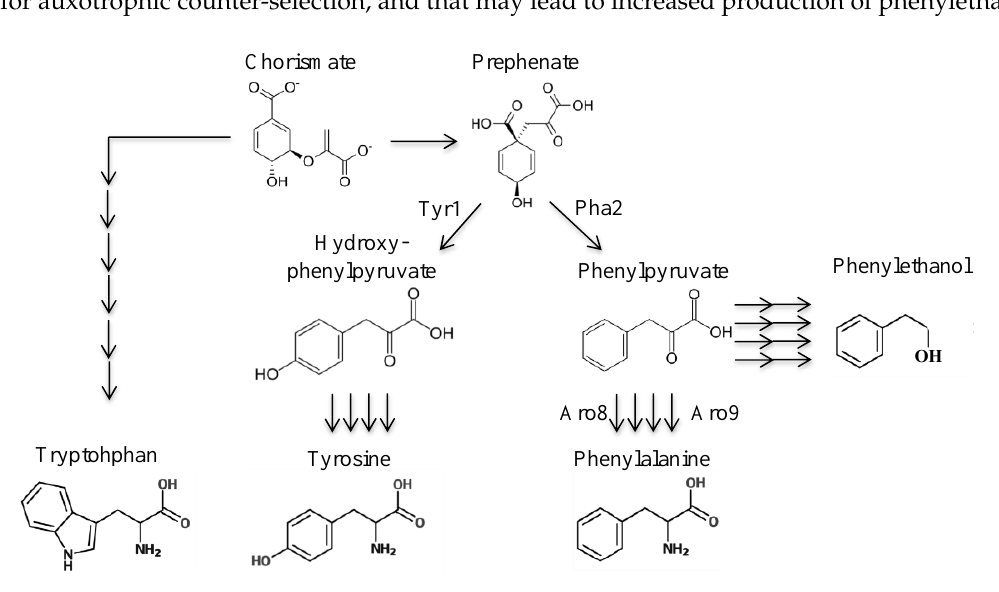
Figure 1. Diagram of the yeast pathway for biosynthesis of tryptophan, tyrosine, and phenylalanine. Number of enzymes and steps are indicated by number of arrows.